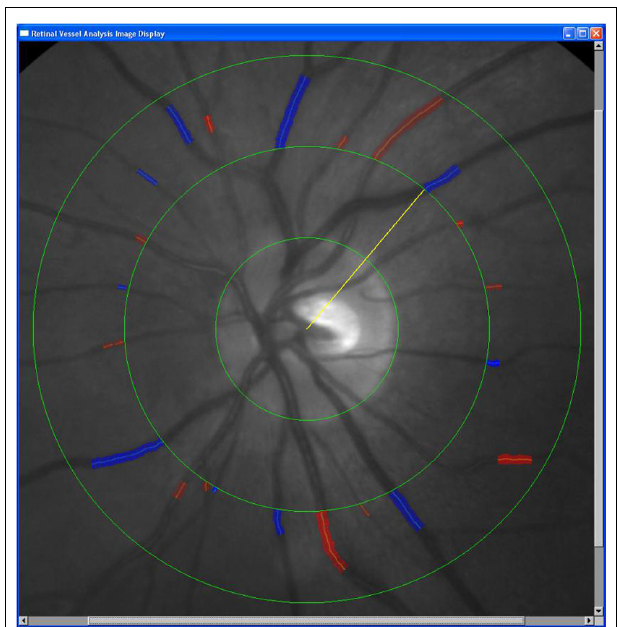
FIGURE 2 | Retinal arteriolar and venular diameters. Semiautomated software (IVAN software, Sydney, NSW, Australia) was used for quantitative analysis. The software employs automatic optic disc detection and measures the caliber of six peripheral retinal arteriolar and venular vessel diameters up to 1 disc diameter (DD) from the optic disc margin. The three rings from the inside to the outside are the Disc diameter ring, 1/ 2DD ring from the optic disc margin, and the 1DD ring from the optic disc margin. The red and blue mark delicate retinal artery and retinal vein, respectively, and the yellow line is the marking line used to measure the vessel diameter.